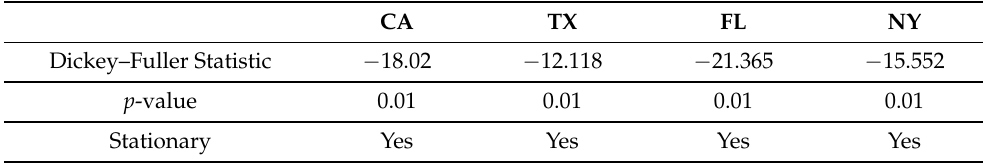
Table 3. Stationary Test Using Augmented Dickey–Fuller